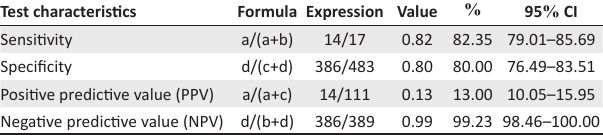
TABLE 5: Sensitivity, specificity and predictive values of the Beck anxiety inventory with reference to the optimal cut-off point of 21.5. Test